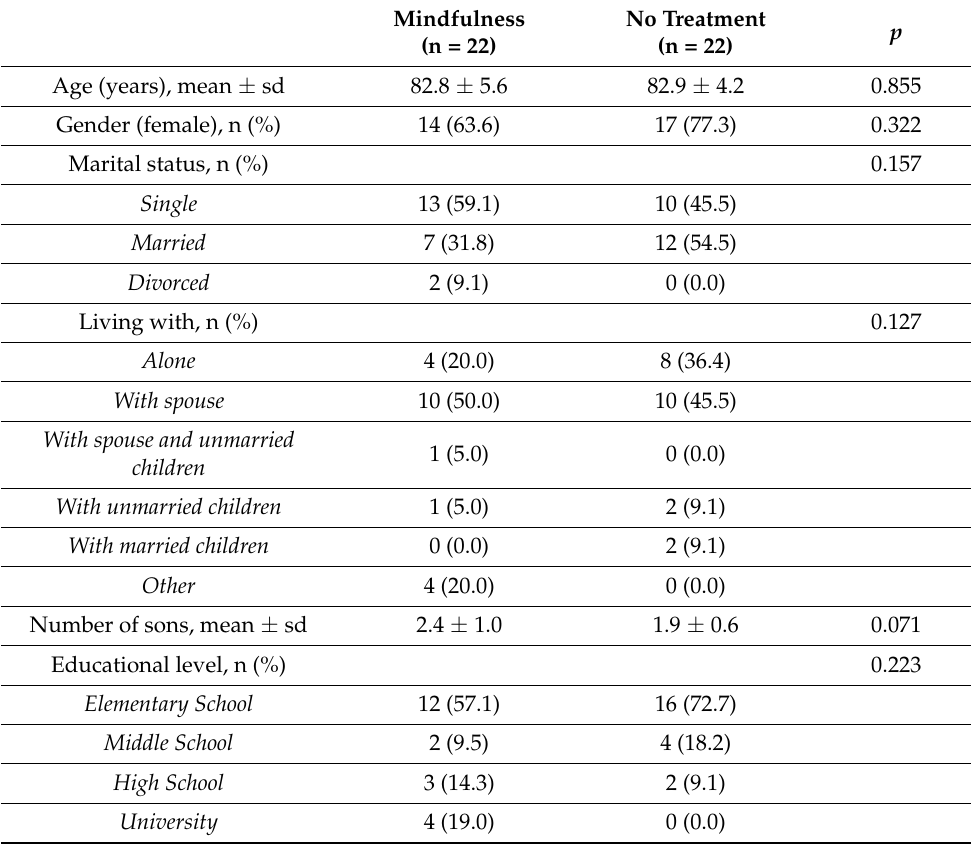
Table 1. Patients-Demographic characteristics (treatment and no treatment